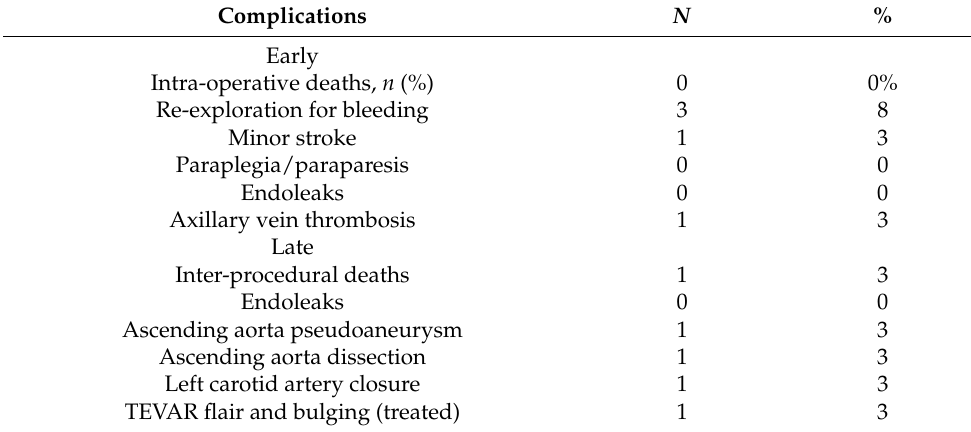
Table 2. Postoperative